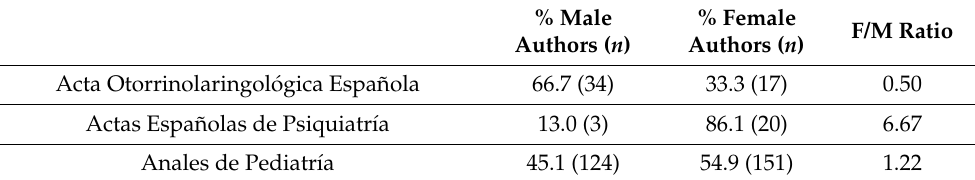
Table 2. Frequency (% and n ) of men and women and female/male (F/M) ratio of article authorship according to journal between April 2020 and May